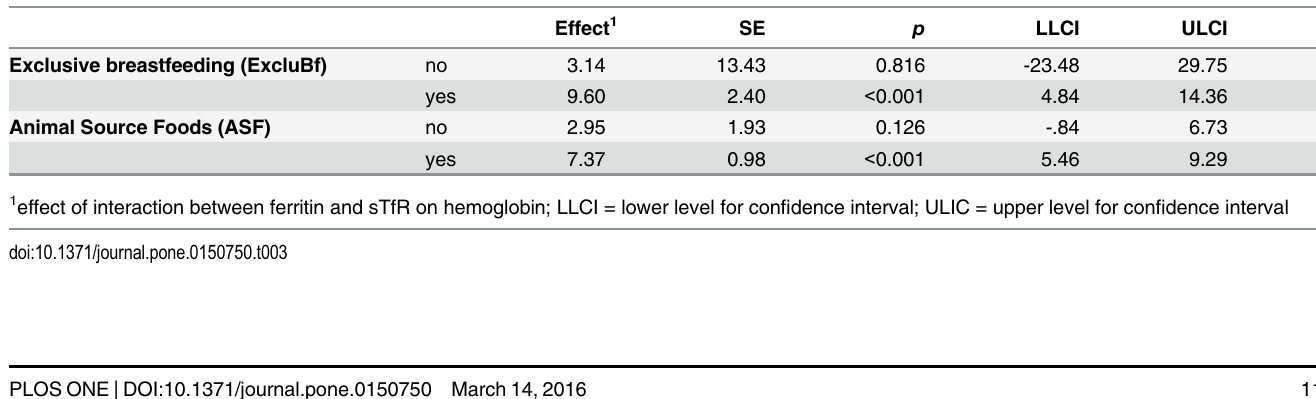
Table 3. Effect sizes of moderator